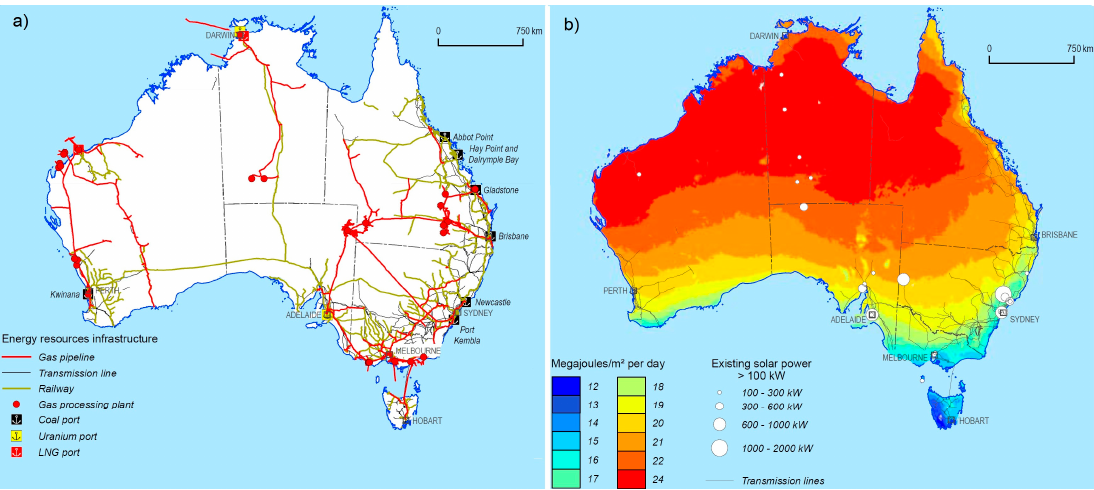
Figure 12. ( a ) Australian natural gas pipeline network and ( b ) Australia average annual solar radiation and electricity transmission lines [17].